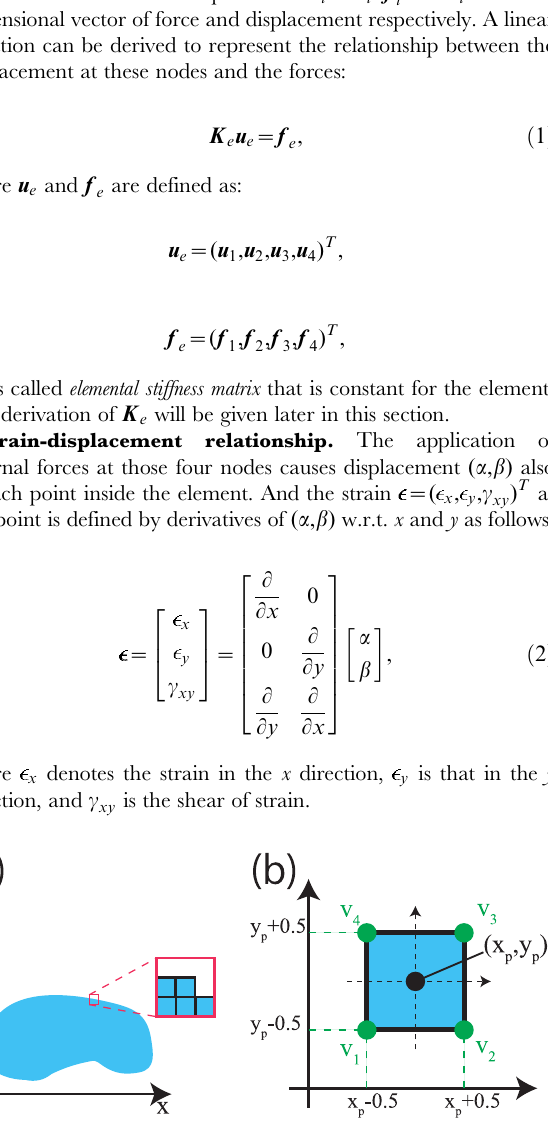
Figure 2. Node definition. (a) is Finite elements and (b) is Nodes of an finite element. The blue area in (a) is an object represented with a set of quadrilateral elements. (b) shows four corner nodes of an element.